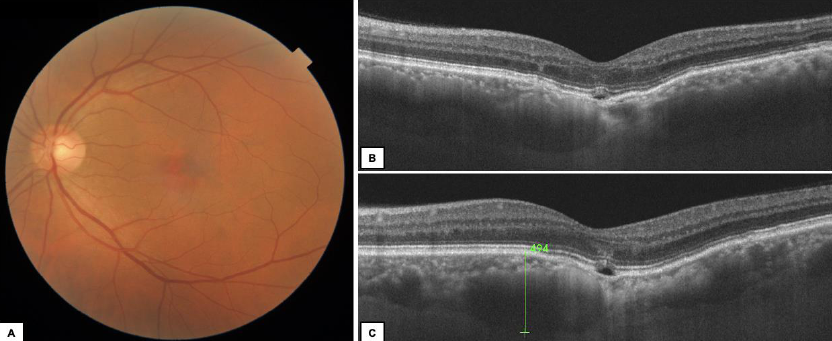
Figure 3. A 64-year-old man with subfoveal FCE type 2 in the left eye. ( A ) Color fundus photography— subtle alteration of the RPE in the fovea; ( B , C ) OCT B-scans—non-conforming FCE with increased CT (494 µ m) and pachyvessels nasally to the lesion ( C ). In 79% of cases, the FCE was subfoveal, while others were located outside the fovea (juxta- or extrafoveally). Subfoveal CT varied from 55 to 285 m (mean 140.36 ± 70.02 m, Me = 129 m) in the affected eye, depending on the location of the FCE — the choroid was the thinnest at the base of the FCE. The maximum CT was observed in the area adjacent to the FCE and ranged from 330 to 517 m (mean 389.86 ± 54.84 m, Me = 379 m), with the presence of pachyvessels. Thirteen patients had normal CT and no presence of pach- ychoroid in their fellow eye. In the healthy eye, the maximum CT was observed in the subfoveal area and ranged from 246 to 518 m (mean 288.07 ± 68.69 m, Me = 269.5 m). We observed pachychoroid features in the fellow eye only in a patient with neovascular- ization (CT = 518 m). OCTA confirmed MNV complicating non – conforming FCE in one eye in a 27-year-old woman (Figure 4).